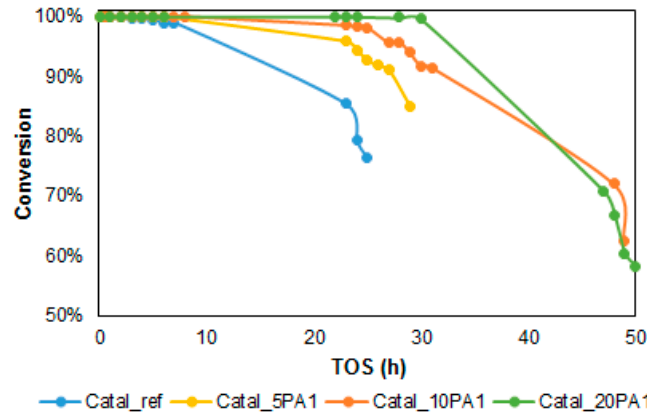
Figure 5. Comparison of the lifetime of as-prepared samples with di ff erent quantities of PA1.